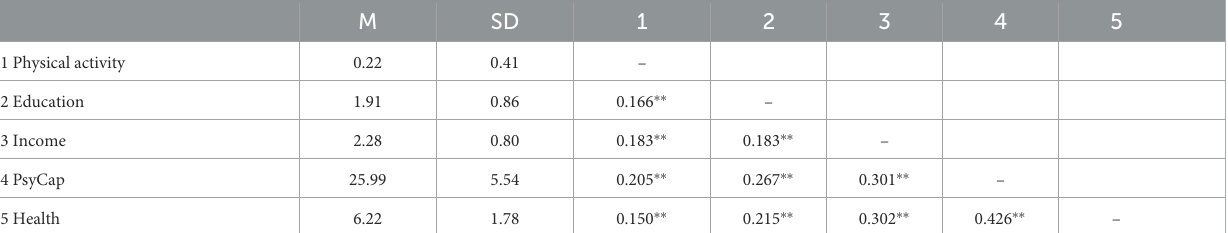
TABLE 1 Correlation matrix of main variables.